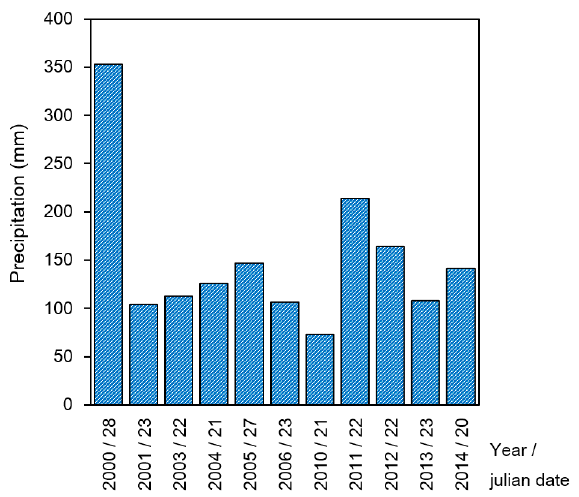
Figure 8. The total precipitation over eight days transformed dry lake beds into ephemeral lakes in potential dry lake bed areas.